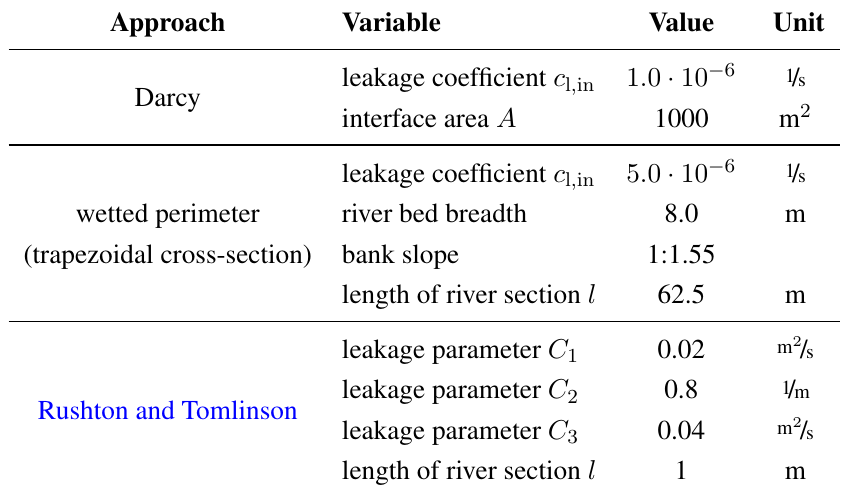
Table 1. Values used to calculate the leakage fluxes for the diagrams in Figure